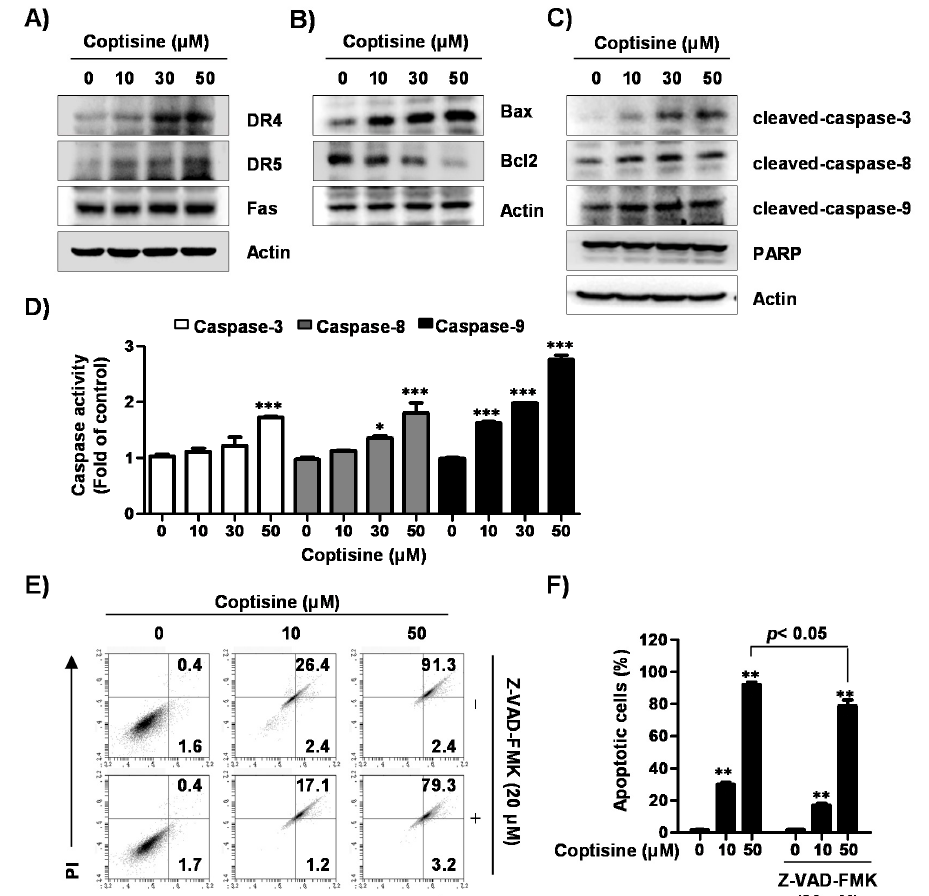
Figure 3. Effects of coptisine on extrinsic and intrinsic apoptotic pathways in Hep3B cells. ( A – C ) Hep3B cells were treated with coptisine for 24 h, cells were harvested for obtain total cell lysates. Cell lysates was separated by sodium dodecyl sulfate polyacrylamide gel (SDS-PAGE) and transferred to polymerization of vinylidene difluoride (PVDF) membranes. The membranes were blocked, probed with indicated antibodies, and incubated with secondary antibodies for detection; ( D ) After cells were treated with the indicated concentration of coptisine for 24 h, cells were harvested, and incubated with each substrate. The activities of caspases were detected by a microplate reader. Data are presented as the mean ± SD of three independent experiments. * p < 0.05 and *** p < 0.001 vs. control; ( E ) After cells were treated with benzyloxycarbonyl-Val-Ala-Asp (OMe) fluoromethylketone (Z-VAD-FMK), a pan caspase inhibitor, for 1 h, cells were treated with coptisine for 24 h. The cells were collected, stained with annexin V-FITC and PI, and analysis by flow cytometry; ( F ) Shows the percentage of annexin V + cells. The results are presented as the mean ± standard deviation (SD) of three independent experiments. ** p < 0.01 vs.